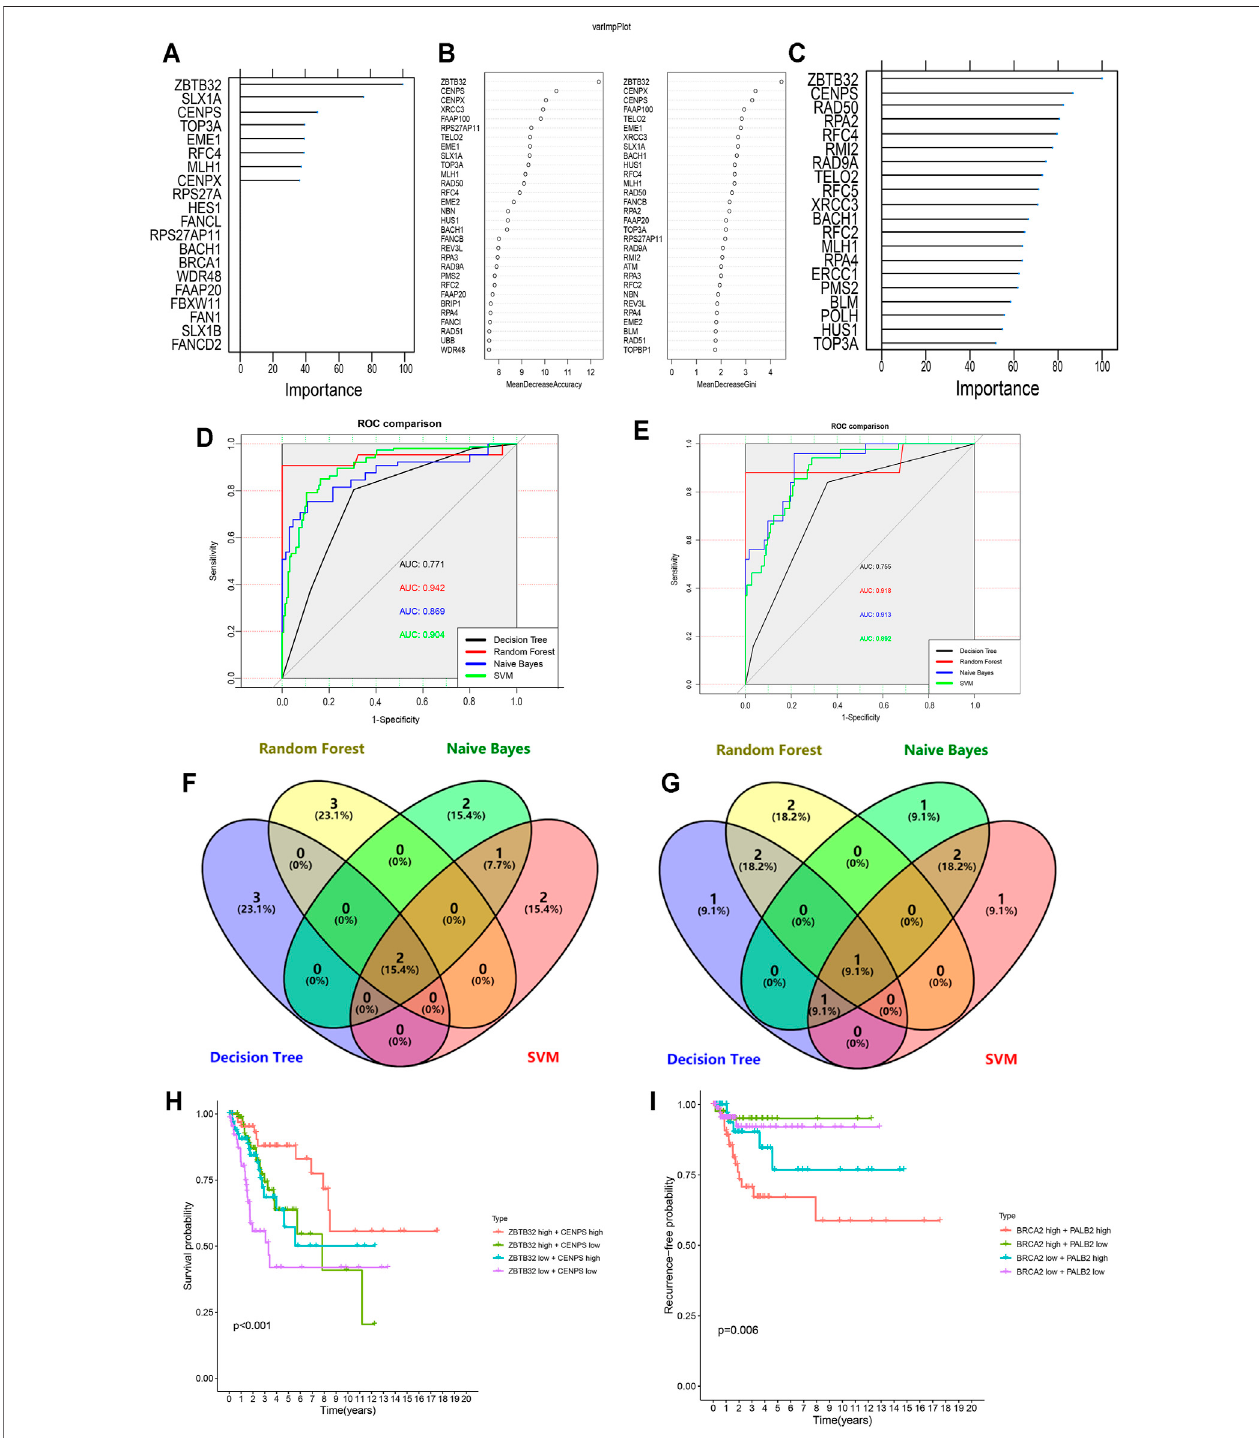
FIGURE6| Machinelearning-basedCCprognosticpredictorforbothOSandRFS. (A,C) Variableimportancescreeningbasedondecisiontree (A) ,randomforest (B) ,andnaïvebayes (C) algorithm. (D,E) ROCcurvesbasedonmachinelearningmethodsforOS (D) andRFS (E) probabilities. (F,G) Venndiagramshowingtheshared candidate genes contained in four machine learning methods for OS (F) and RFS (G) . (H) Multivariate Kaplan-Meier survival curves for patients with different expression of ZBTB32 and CENPS , which were fi ltered by LASSO-Cox regression algorithm and machine learning methods for OS. (I) Multivariate Kaplan-Meier survival curves for patients with different expression of PALB2 and BRCA2 , which were fi ltered by LASSO-Cox regression algorithm and machine learning methods for RFS.